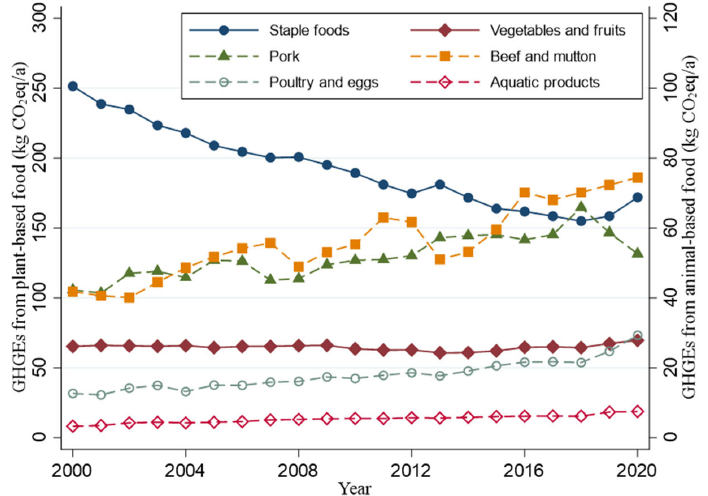
Figure 4. Per capita diet ‐ related agricultural GHGEs from 2000 to 2020.